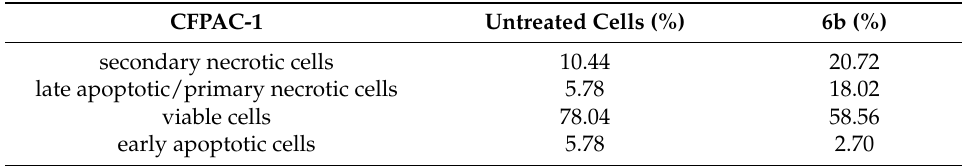
Table 2. Annexin V assay for apoptosis detection in CFPAC-1 cells a .